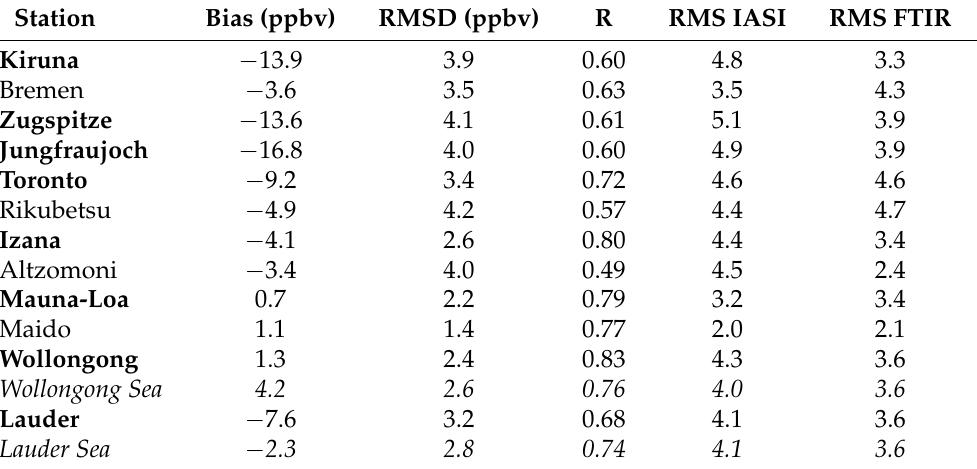
Table 4. Statistics of FTIR versus SOFRID N 2 O comparisons in the MT (700–350 hPa).